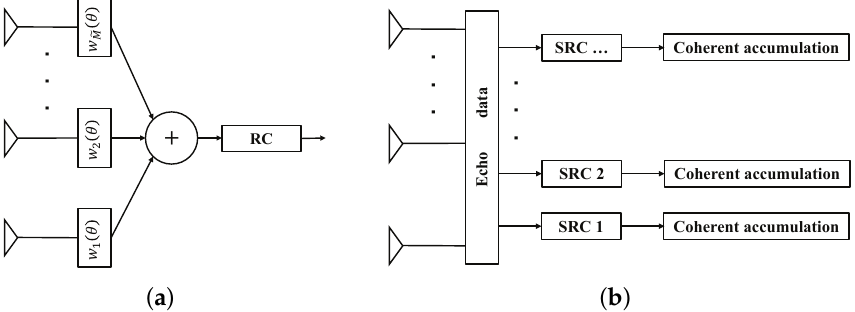
Figure 1. The introduced signal processing scheme. ( a ) The details of each SRC. ( b ) The signal processing